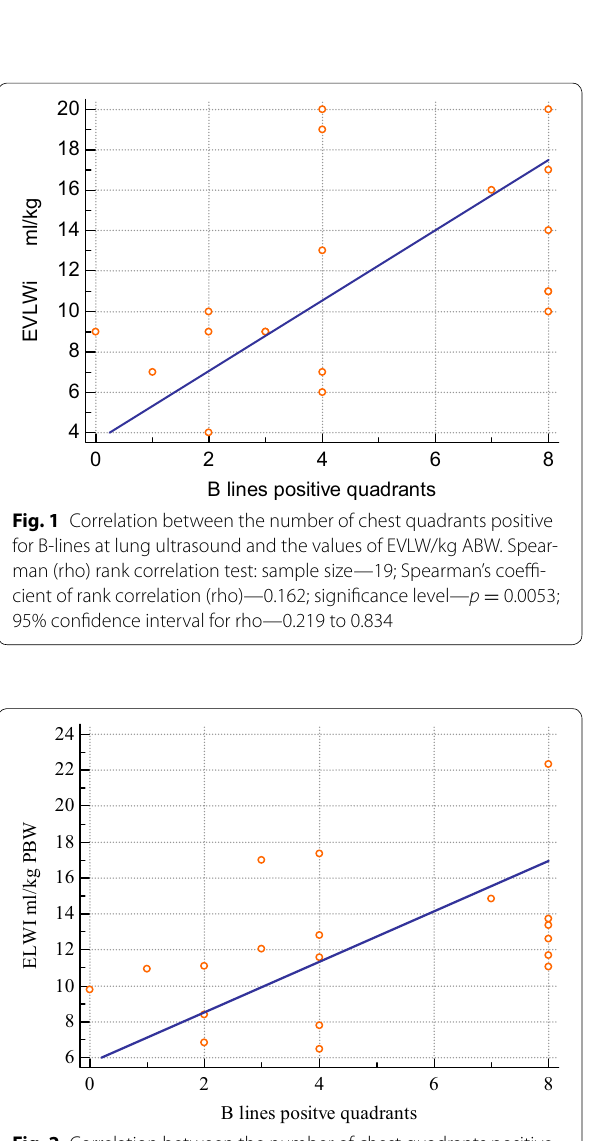
Fig. 2 Correlation between the number of chest quadrants positive for B-lines at lung ultrasound and the values of EVLW/kg PBW. Spear- man (rho) rank correlation test: sample size—19; Spearman’s coef- ficient of rank correlation (rho)—0.493; significance level— p 95% confidence interval for rho—0.499 to